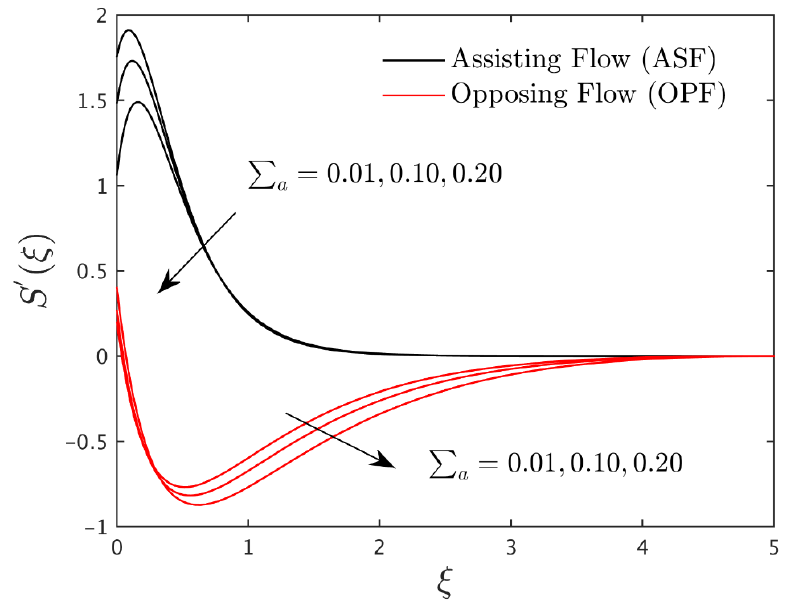
Figure 4. Velocity profile for the case of ASF and OPF due to variations in the values of Σ a